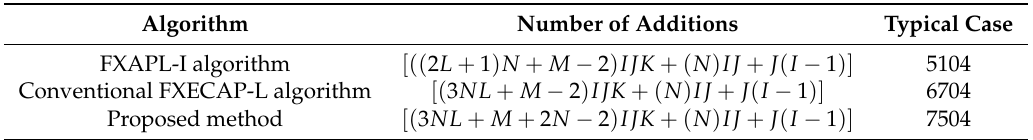
Table 2. Number of additions per iteration of the FXAPL-I algorithm, conventional